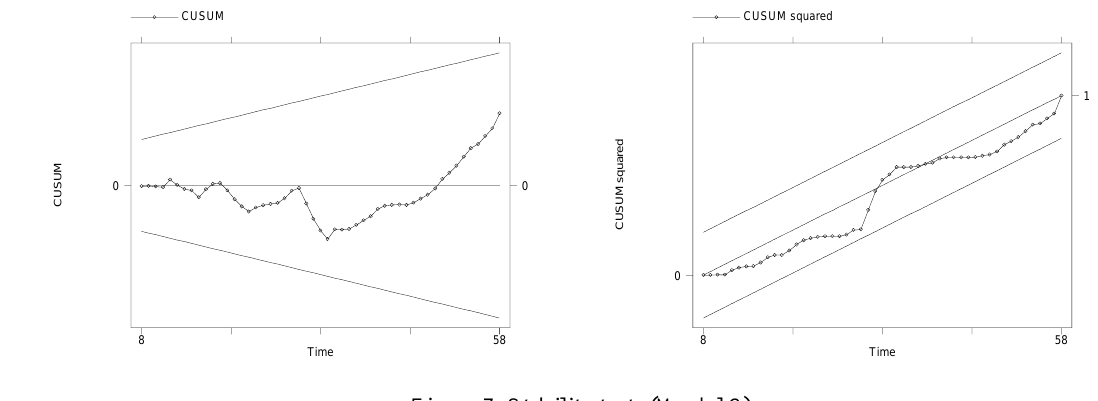
Figure 7. Stability tests (Model 2)